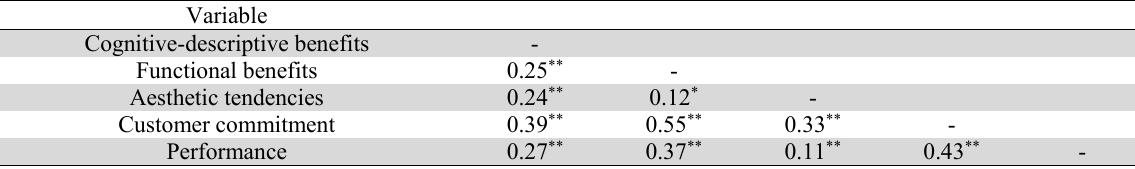
Correlation matrix of variables